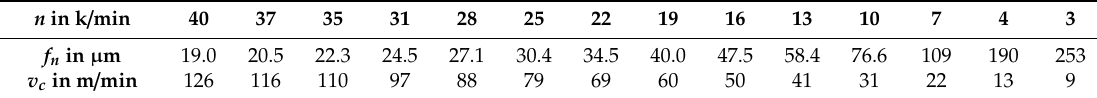
Table 2. Cutting speed variation